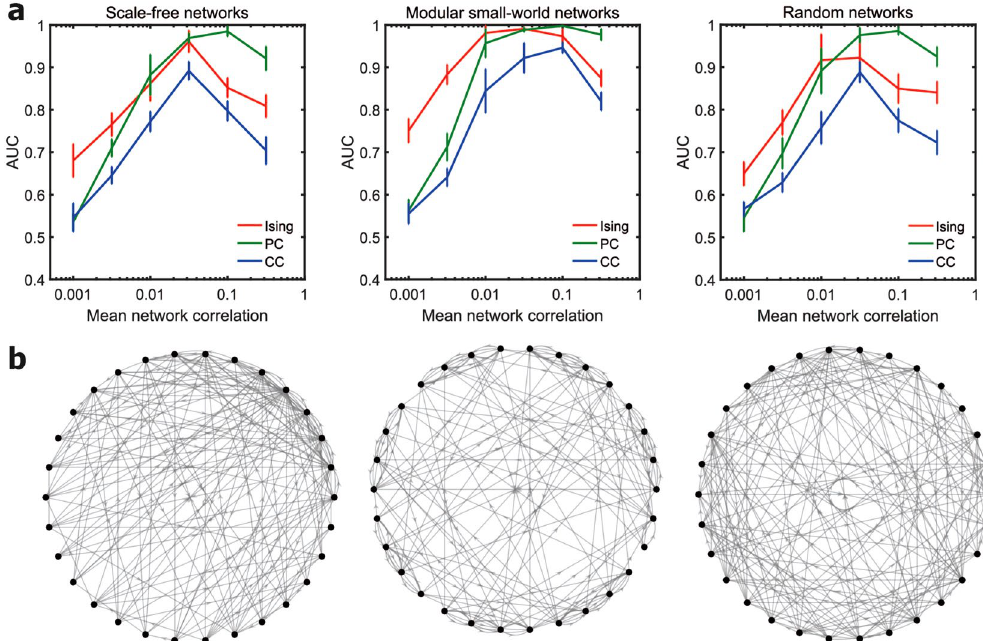
Figure 3. Effect of network topology. (a) Plot of the AUC values for networks of 30 neurons with scale- free (SF), small-world (SW) and Erdos-Renyi (ER) random network topologies. Data was averaged over ten simulated networks for each network condition. Firing rate was fixed at 20 Hz in all cases. All the three topologies had the same link density of 0.2. (b) An example of the structural connectivity network for each topology. Scale-free networks form a few highly connected hub nodes. Modular small-world networks present a balance of segregation and integration via dense intra-module connections and sparse inter-module connections. Most nodes in random networks have a degree in the vicinity of the average degree of the network.